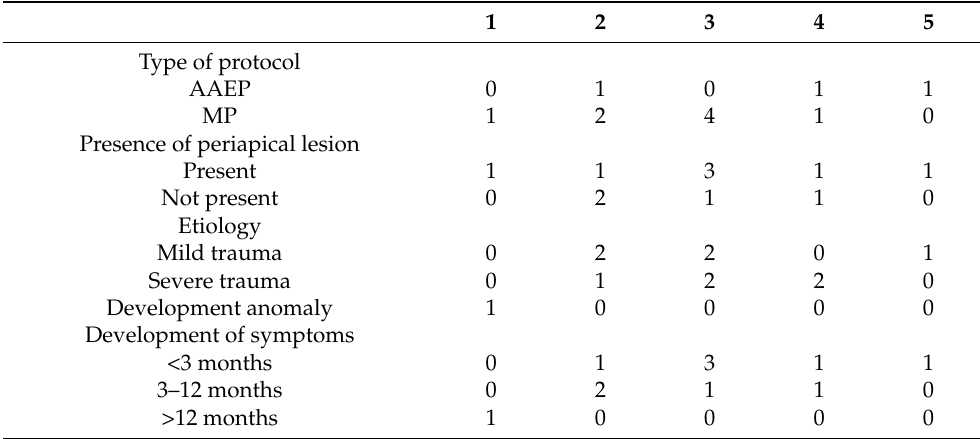
Table 2. Distribution of patients according to values of periapical index (PAI), type of protocol, presence of periapical lesion and etiology observed after two